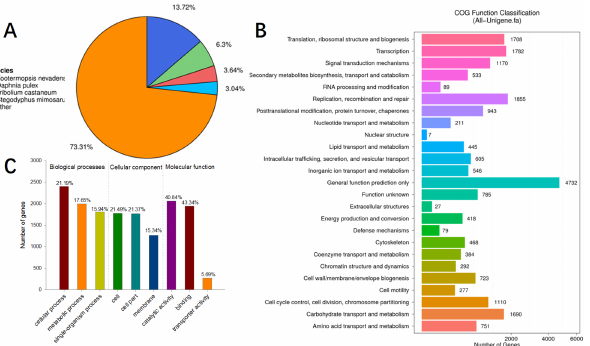
Fig 1. Functional annotation and classification of Macrobrachium rosenbergii intestine transcriptome sequences. (A) Species distribution of the BLASTx matches of the transcriptome unigenes. This figure showed the species distribution of unigene BLASTx matches against the Nr protein database (cut-off value E < 10–5) and the proportions for each species. (B) Functional distribution of COG annotation. (C) Top 10 of the GO